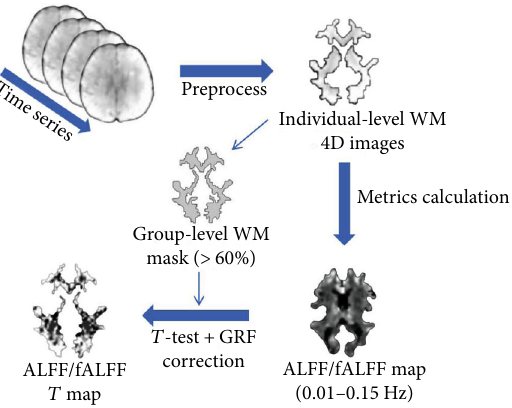
Figure 1: Flow chart of preprocessing, metric calculation, and statistical analysis in this